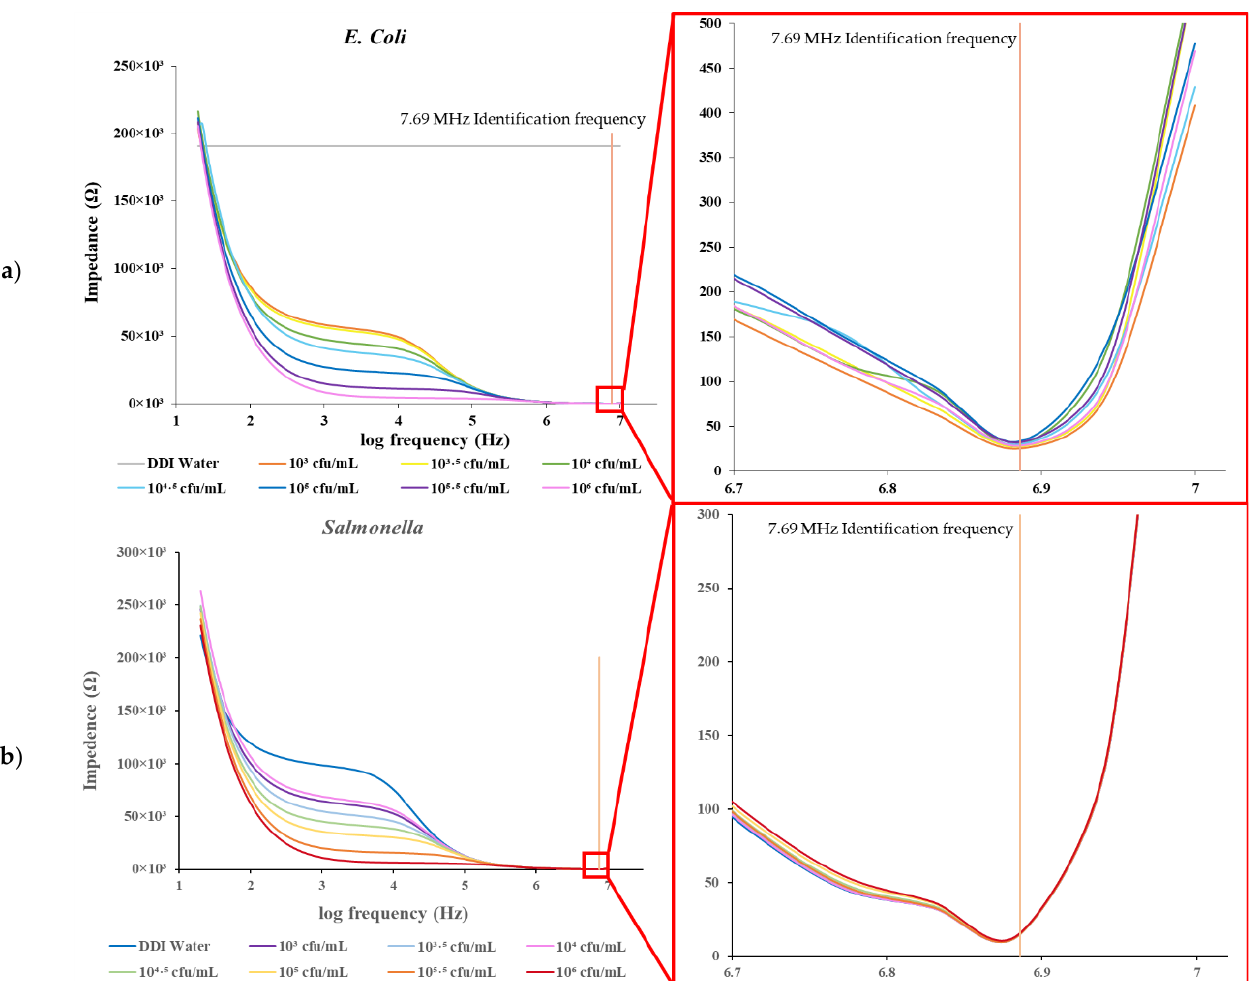
Figure 4. Impedance spectrum of ( a ) E. coli and ( b ) Salmonella samples.